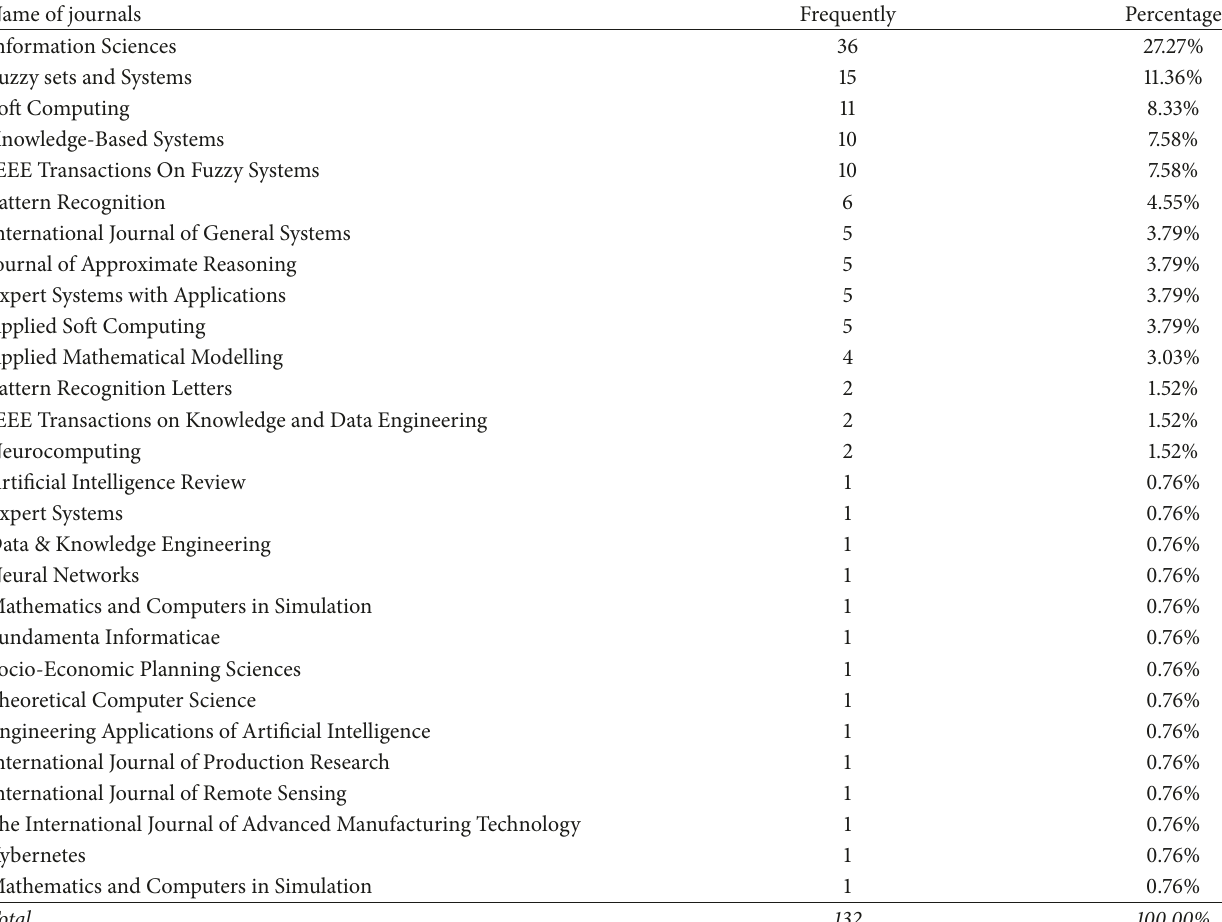
Table 8: Distribution of papers based on the name of